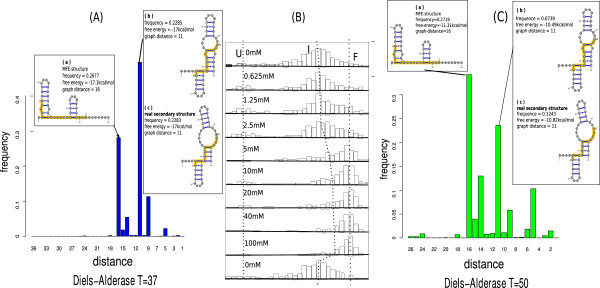
Relation between graph-distance distribution and smFRET data. (A) The graph-distance distribution of a Diels-Alderase (DAse) ribozyme at temperature 37°C. Structures (a), (b) and (c) are the top three secondary structures considering their free energy: the minimum free energy structure is shown in (a), (c) is the experimentally determined secondary structure, which is ranked as the 3rd best sub-optimal structure with RNAsubopt -e. The graphic representations of these structures are produced with VARNA[20]. (B) The corresponding smFRET efficiency (Efret) histograms are reported in [12]. From these data, three separate states of the DAse ribozyme can be distinguished, the unfolded (U), intermediate (I) and folded (F) states. (C) The graph-distance distribution in the ensemble which is approximated with RNAsubopt -p at temperature 50°C.